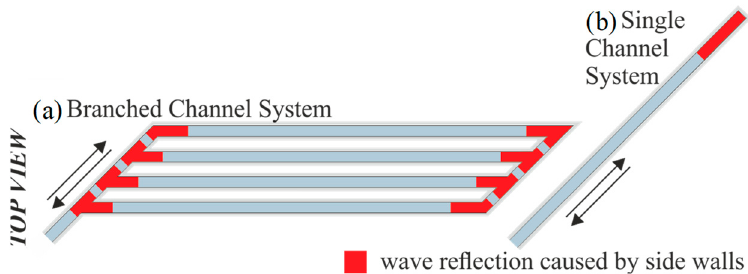
Figure 4. Wave reflection points in the branched channel system ( a ) and in the single channel system ( b ).